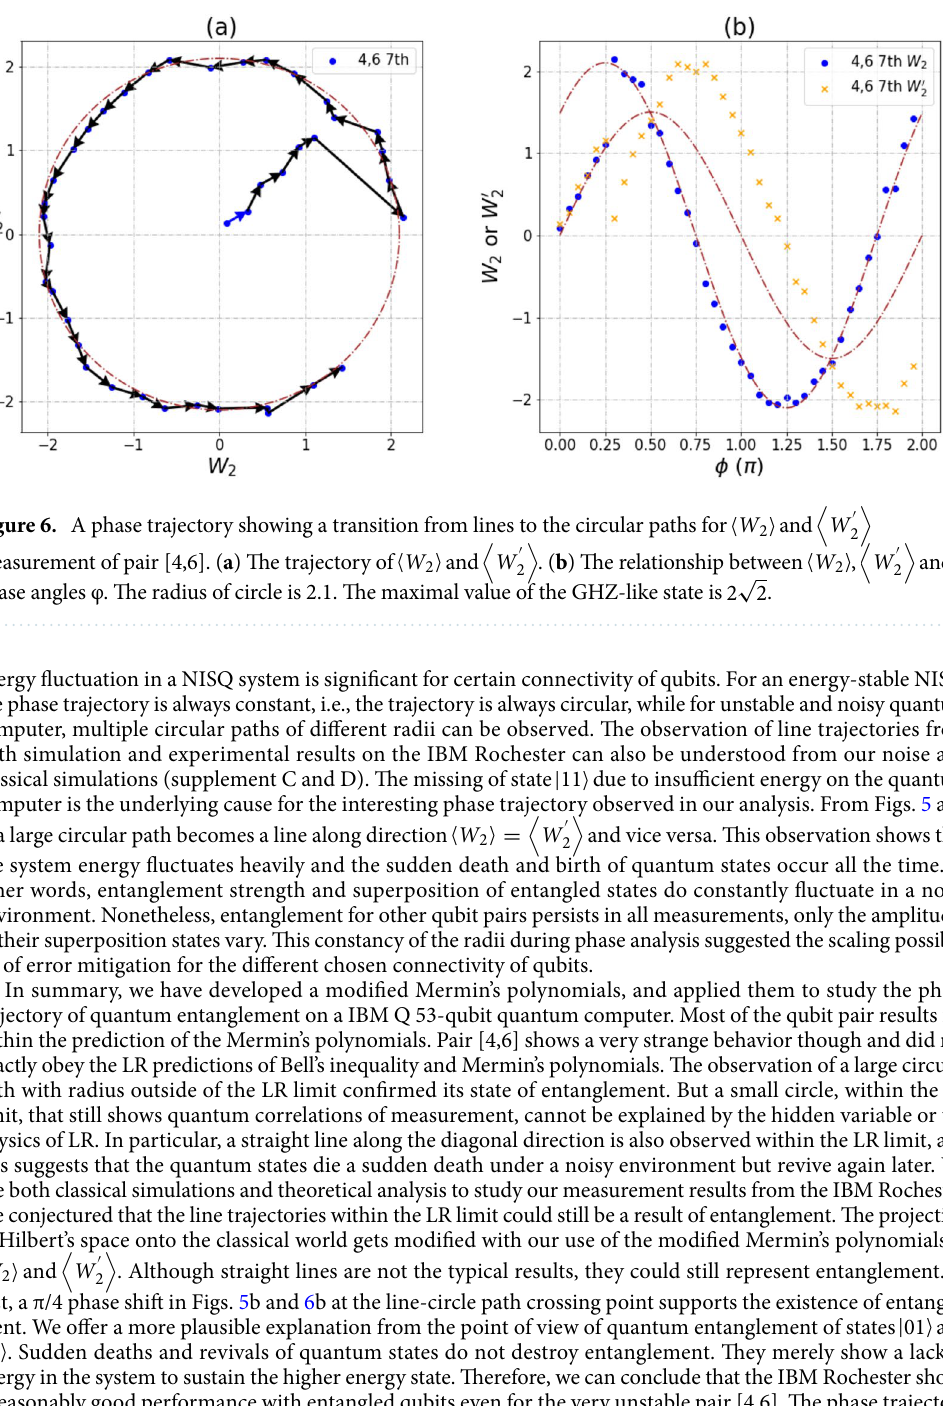
Figure 6. A phase trajectory showing a transition from lines to the circular paths for